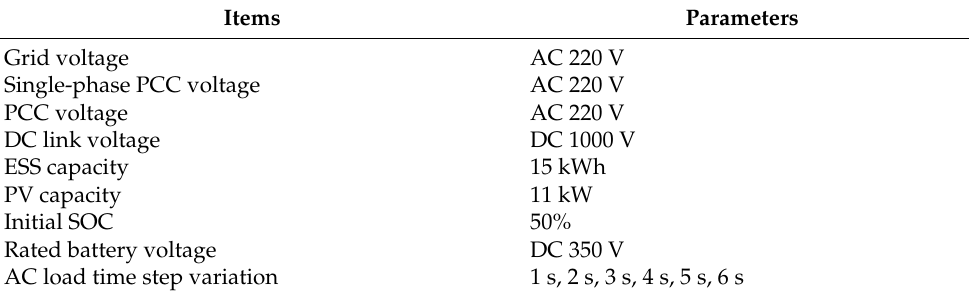
Table 1. System Parameters.